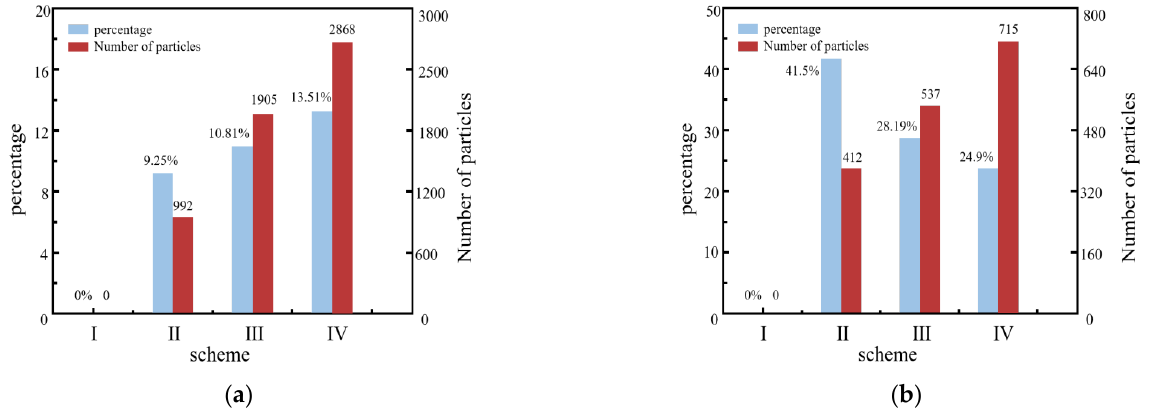
Figure 13. ( a ) The number of particles on the hull and their share in the number of wave particles and ( b ) number of returning particles and their share in the number of particles in the